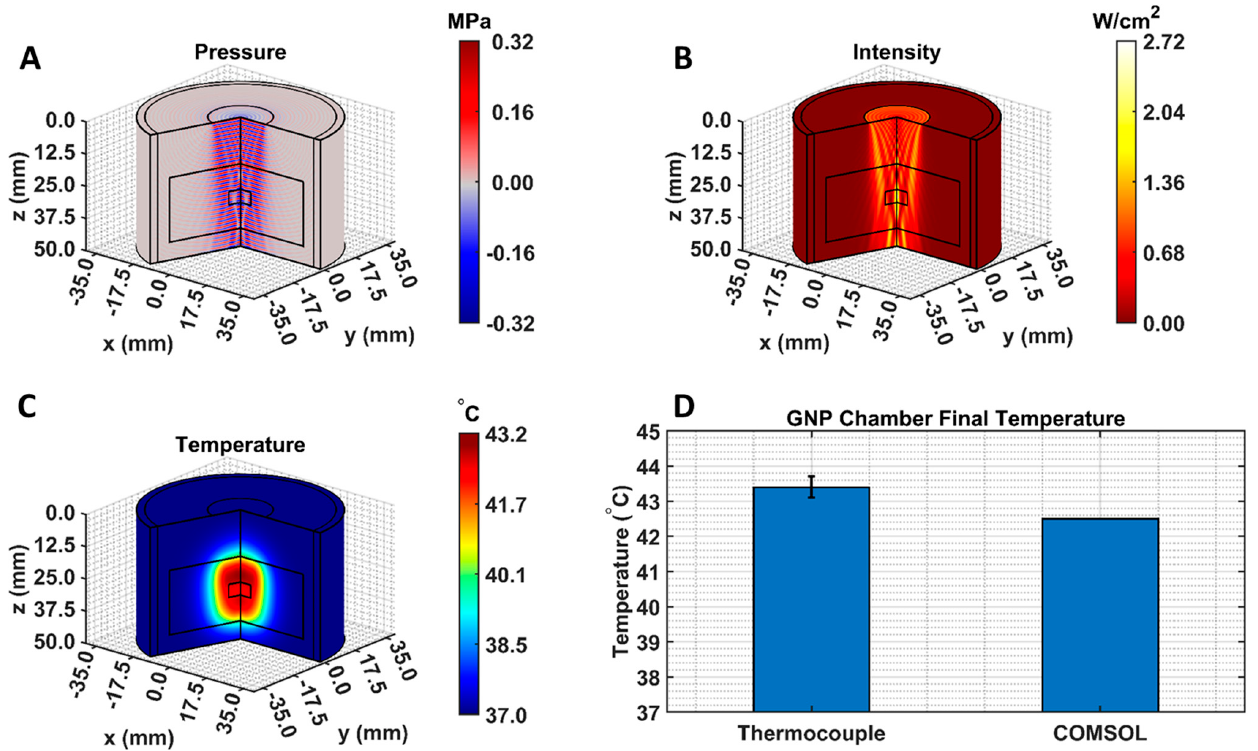
Figure 4. COMSOL-simulated ( A ) pressure, ( B ) intensity, and ( C ) thermal fields. Black lines indicate the LIPUS transducer, porcine tissue domain, and GNP chamber domain. The 2D fields were rotated about the axis of symmetry to produce axisymmetric 3D plots; ( D ) a comparison between the experimental thermocouple measured and the COMSOL-simulated average GNP chamber temperature, reached after 5 min of LIPUS exposure.